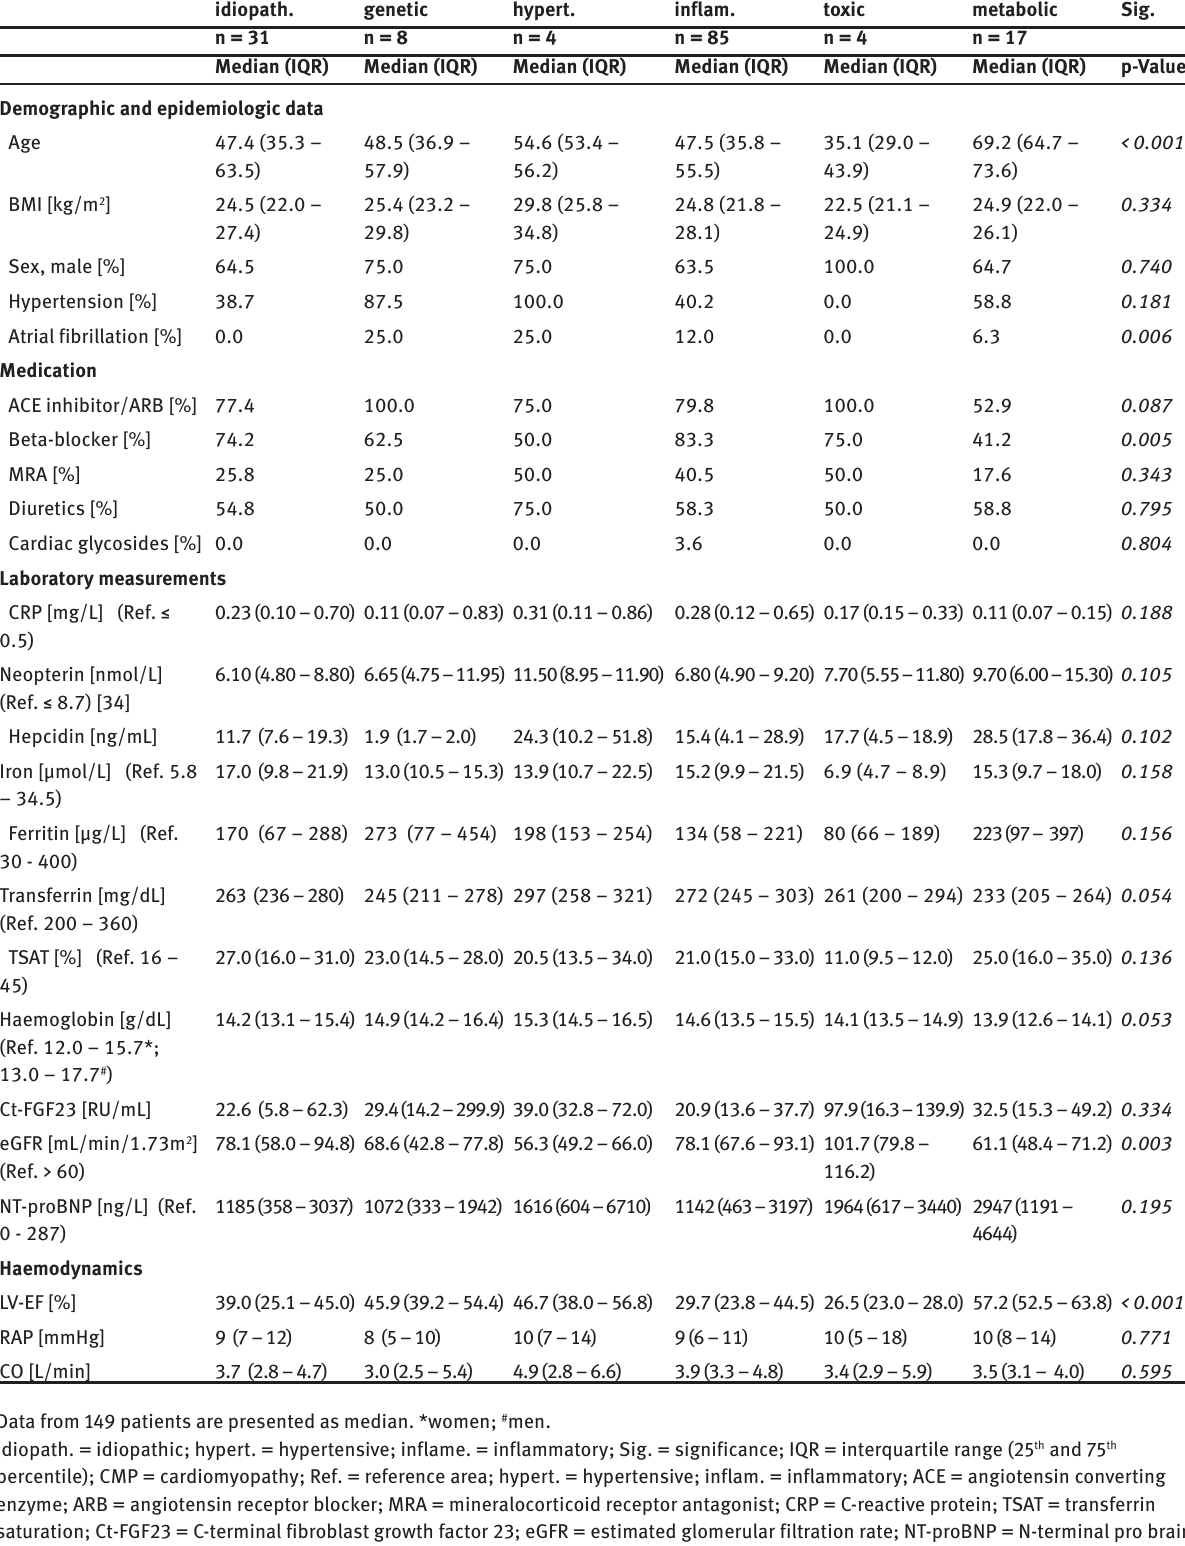
Table 2: Laboratory measurements according to the CMP aetiology classification. idiopath. genetic hypert. inflam. toxic metabolic